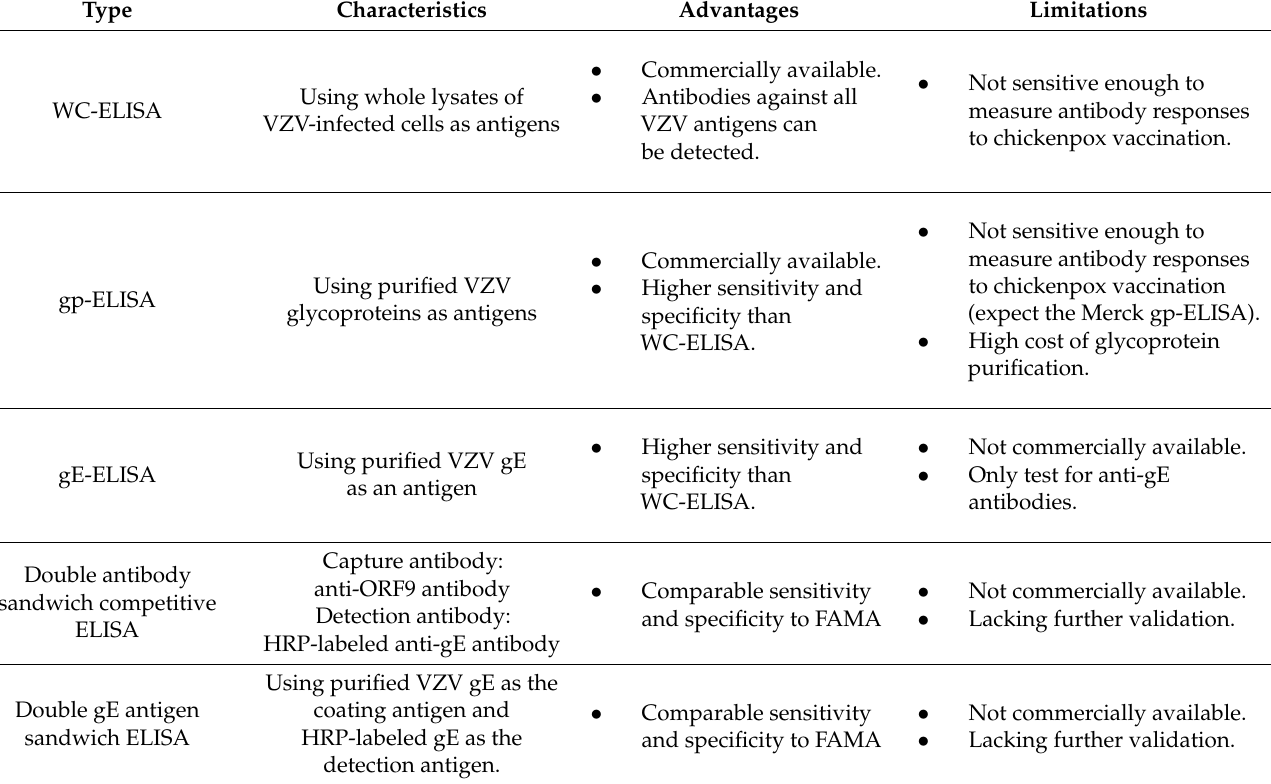
Table 2. Comparison of ELISAs for detecting anti-VZV